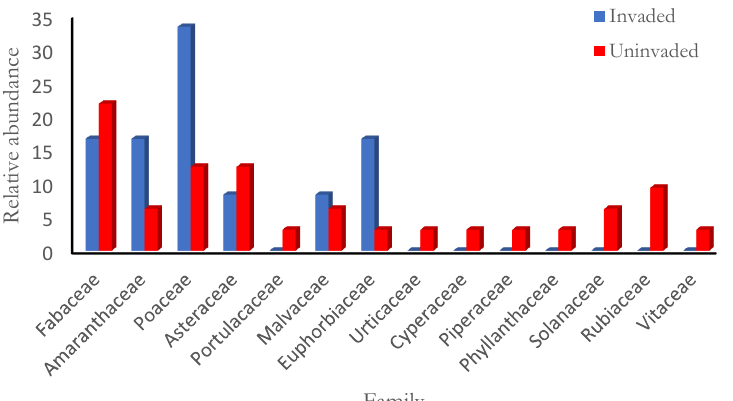
Figure 1. Families of plant species in the standing vegetation of the studied plots